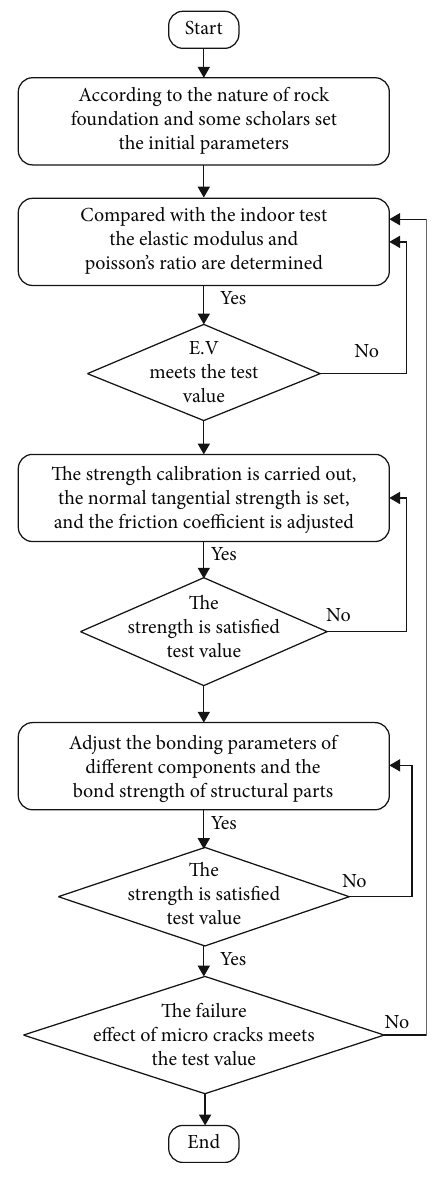
Figure 7: Calibration process of mesoscopic parameters in the numerical